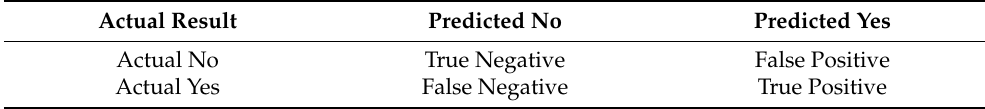
Table 2. Confusion matrix with attributes.